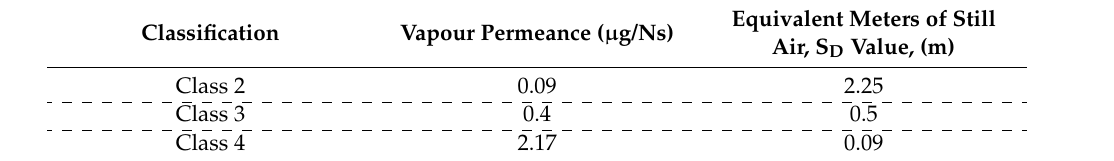
Table 4. Hygrothermal properties of the materials used in the multi-layered assemblies within the WUFI simulations.